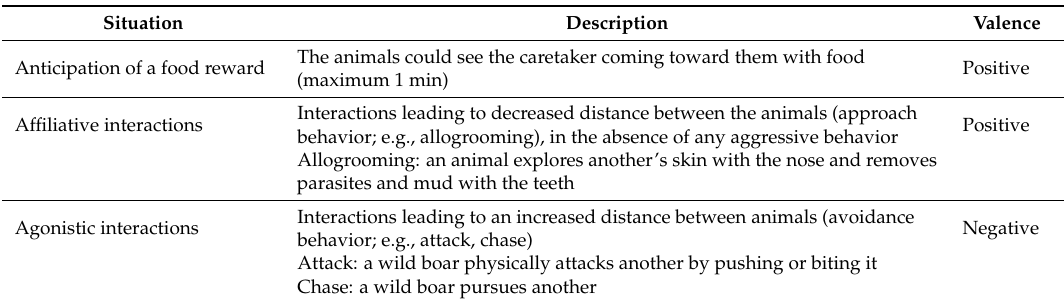
Table 1. Description of the recording situations, along with the associated behaviors and putative valence